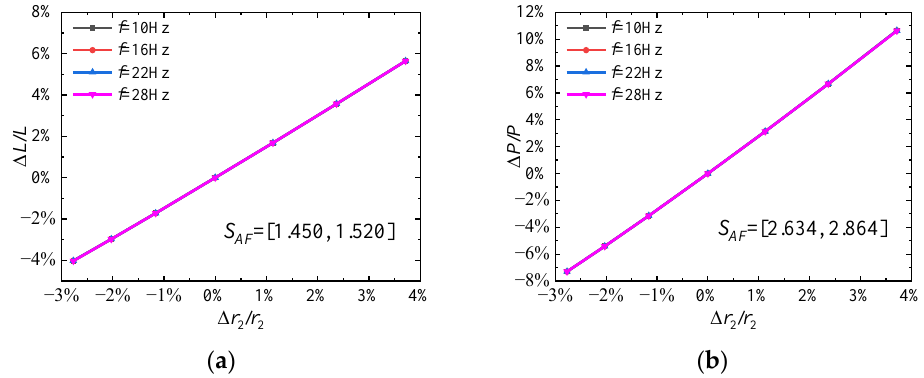
Figure 9. Sensitivity analysis for the dimensionless radius of the second moment of area r 2 by changing the location of c max . ( a ) Variation of lift vs. variation of r 2 . ( b ) Variation of aerodynamic power vs. variation of r 2 .